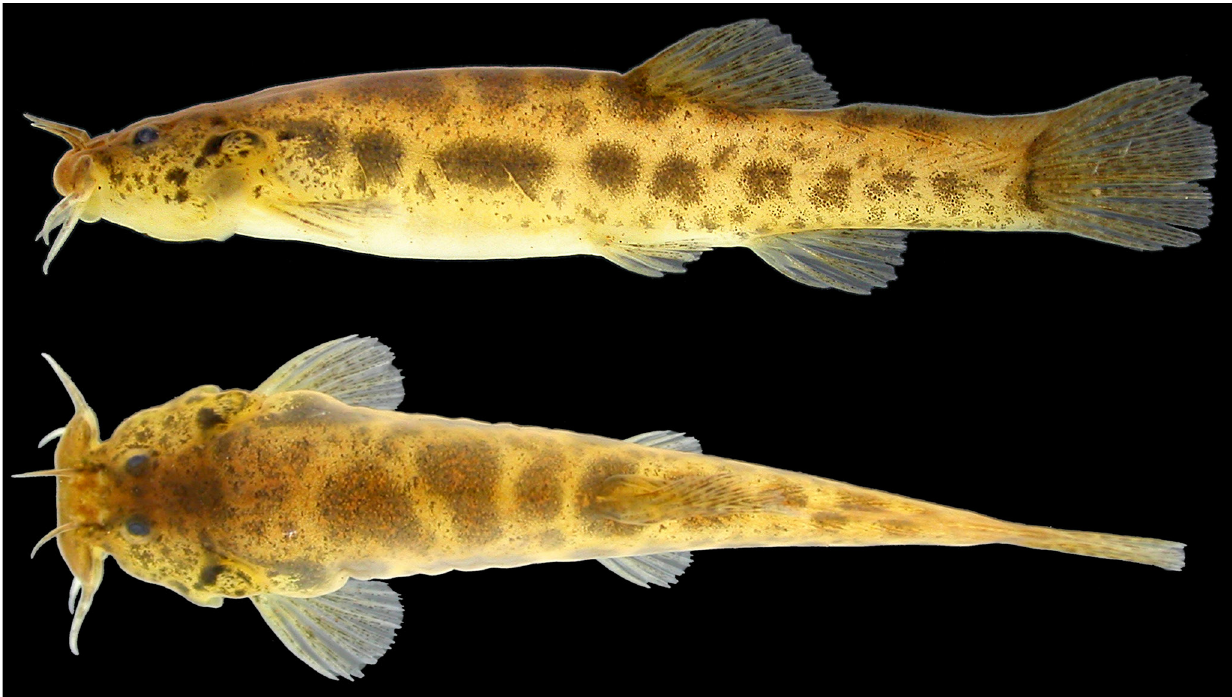
FIGURE 15 | Specimen just after the fixation in formalin of Scleronema milonga , new species, paratype (UFRGS 7685; 32.7 mm SL), Brazil, Rio Grande do Sul, São Nicolau, unnamed stream tributary to rio Ijuí, lower rio